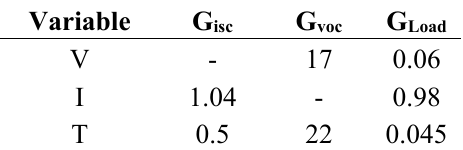
Table 3. Sensitivity analysis of the estimation approaches in dependence of their main parameters.